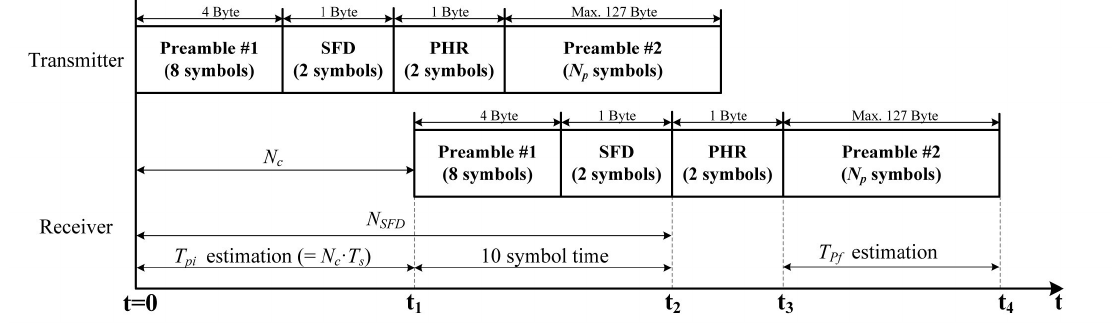
Figure 3. TOA integer-part